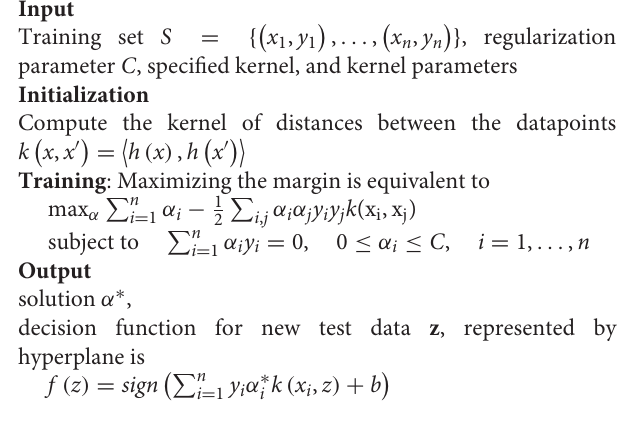
which is frequently used for the small sample case (Dora et